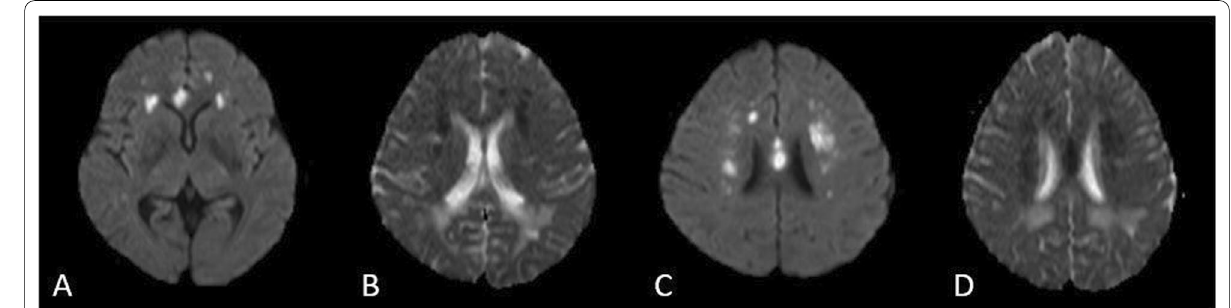
Fig. 2 A and C Showing DWI with B and D showing ADC images of multiple foci of diffusion restriction involving genu and body of corpus callosum and bilateral periventricular white matter suggestive of acute lacunar infarcts